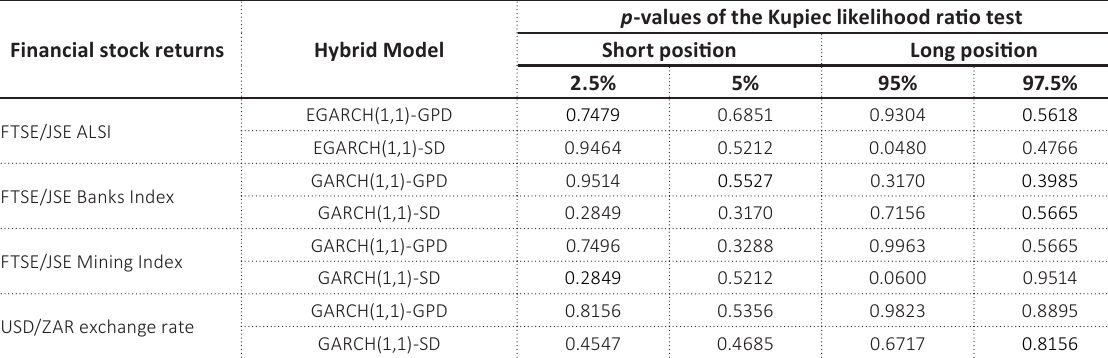
Table 8. p -values of the Kupiec likelihood ratio test for financial indices and exchange rate returns Financial stock returns